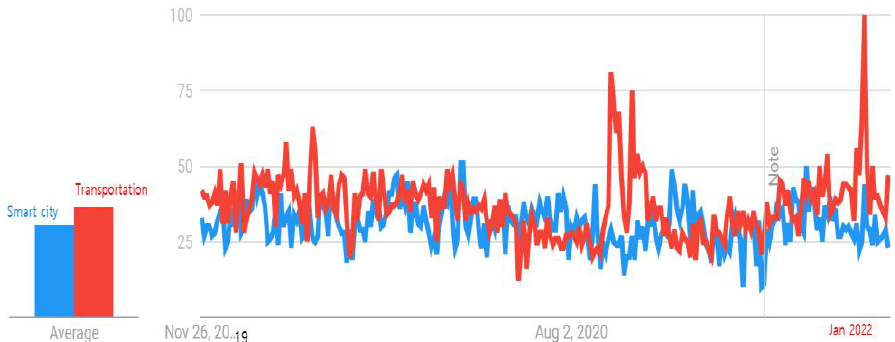
Figure 7. Comparison between number of projects in a smart city and transportation in Germany (2018 – 2022). Source: Google Trends https://trends.google.com/trends/explore (accessed 22 December 2022) [42].